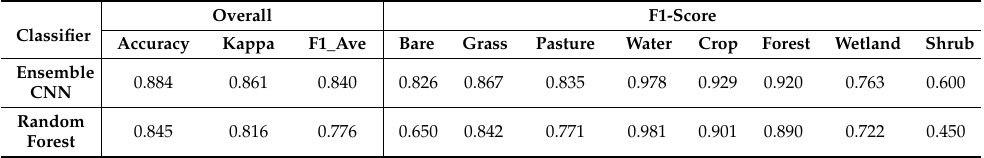
Table 1. Comparison of the ensemble CNN and random forest